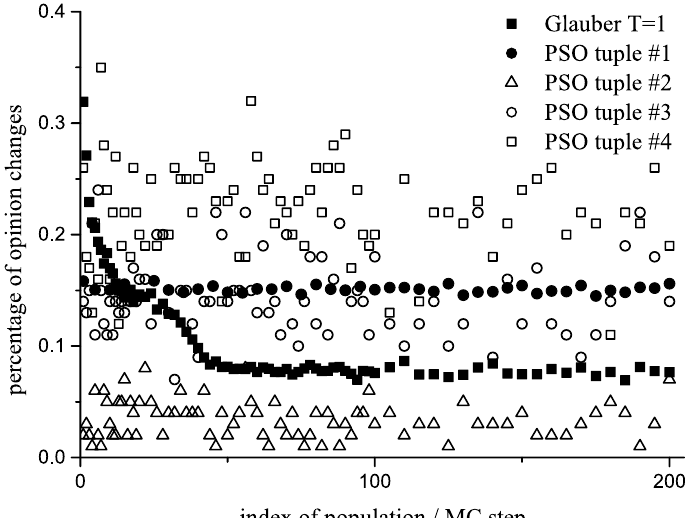
Fig. 8. The number of opinion changes in selected single run: tuple#1: f 1,10,0.1,0.1,0.75,0.95,0.25 g ,